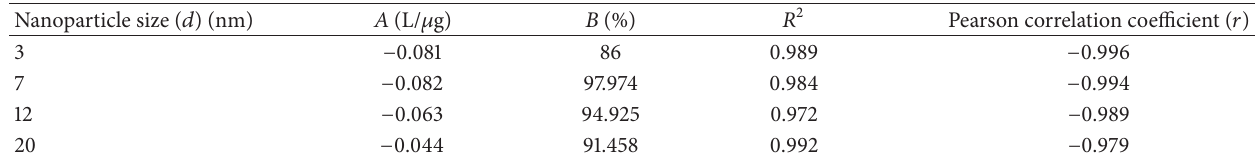
Table 1: Parameters used for fitting of the straight lines to the experimental data showing the variation of the ratio percentage of the number density of cells in CS ( 𝜉 ) of Mystus tengara with increasing ZnS nanoparticle concentration ( 𝜎 ) for a fixed exposure time ( 𝑡 = 60 days) keeping nanoparticle size ( 𝑑 ) as a parameter and the correlation coefficients between 𝜉 and 𝜎 for a fixed 𝑑 . Nanoparticle size ( 𝑑 ) (nm)